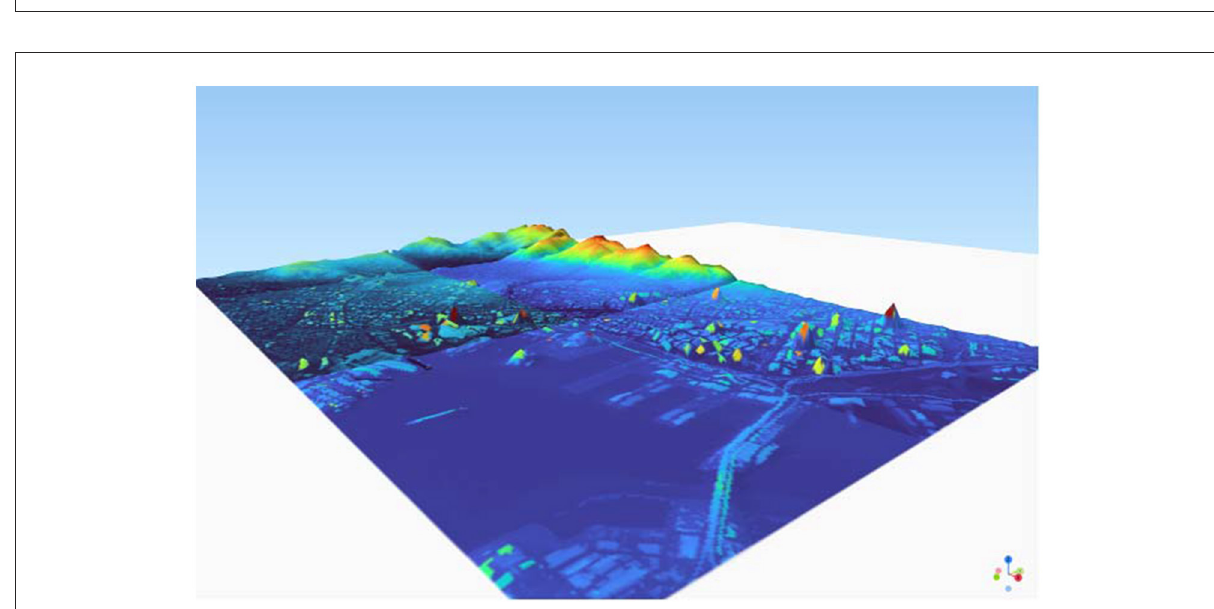
FIGURE8 Reproduction of buildings in the vicinity of Sannomiya to Nagata in Hyogo Prefecture from DSM